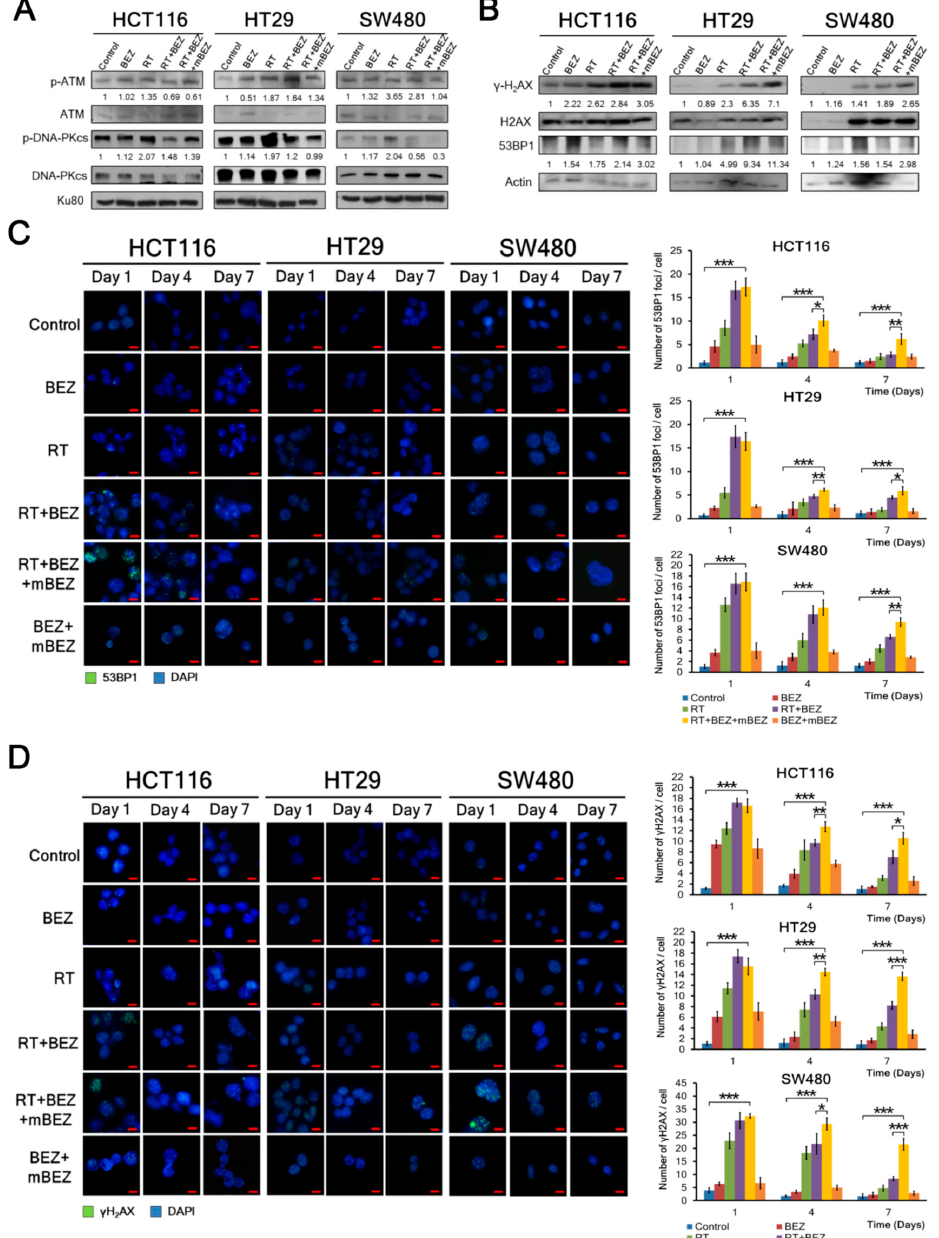
Figure 4. BEZ235 maintenance treatment following RT + BEZ235 treatment increased the susceptibility of CRC cells to radiation by inhibiting DNA repair mechanisms and increasing the effects of DNA damage. ( A ) BEZ235 maintenance treatment following RT + BEZ235 treatment significantly inhibited p-ATM and p-DNA-PKcs in three CRC cell lines compared to the BEZ235, RT, RT + BEZ235, and control treatments. The relative amounts of phosphorylated and non- phosphorylated proteins were quantified. The relative ratio of the control group was defined as 1. ( B ) RT + BEZ235 treatment followed by BEZ235 maintenance treatment significantly increased γ -H2AX and 53BP1 expression in three CRC cell lines compared to the BEZ235, RT, RT + BEZ235, and control treatments. ( C ) Cells were treated as described in Figure 1A and labeled with anti-53BP1 primary antibody and DyLight 488-conjugated secondary antibody on days 1, 4, and 7 of the treatment period.